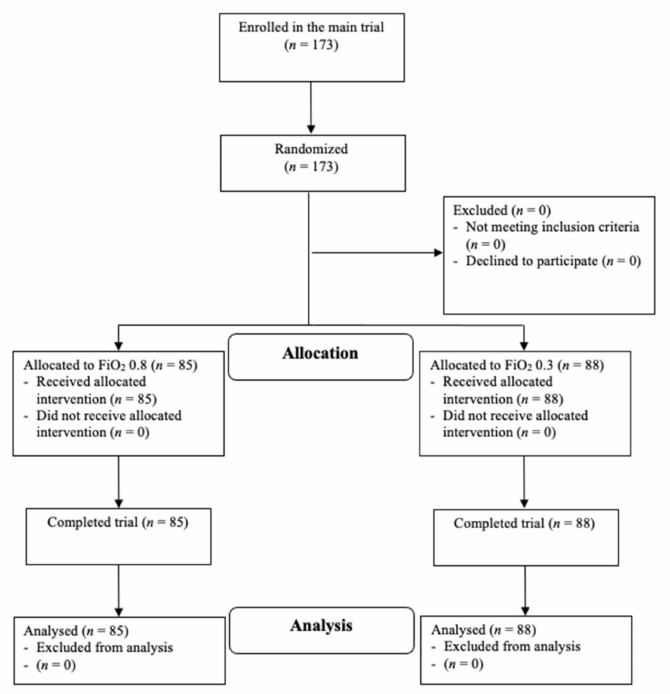
Figure 1. Patient Flow Diagram; Design and Form in Accordance with the 2010 CONSORT Guide- lines